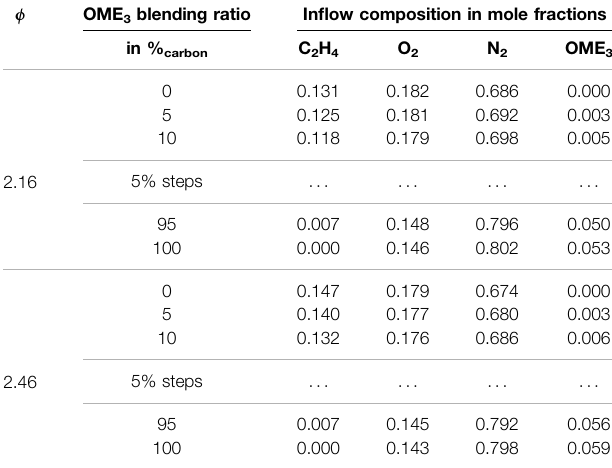
TABLE1| In fl owmixturecompositionsoftheinvestigated fl ames.Entriesfor15to 90 % carbon of OME 3 blending are omitted for